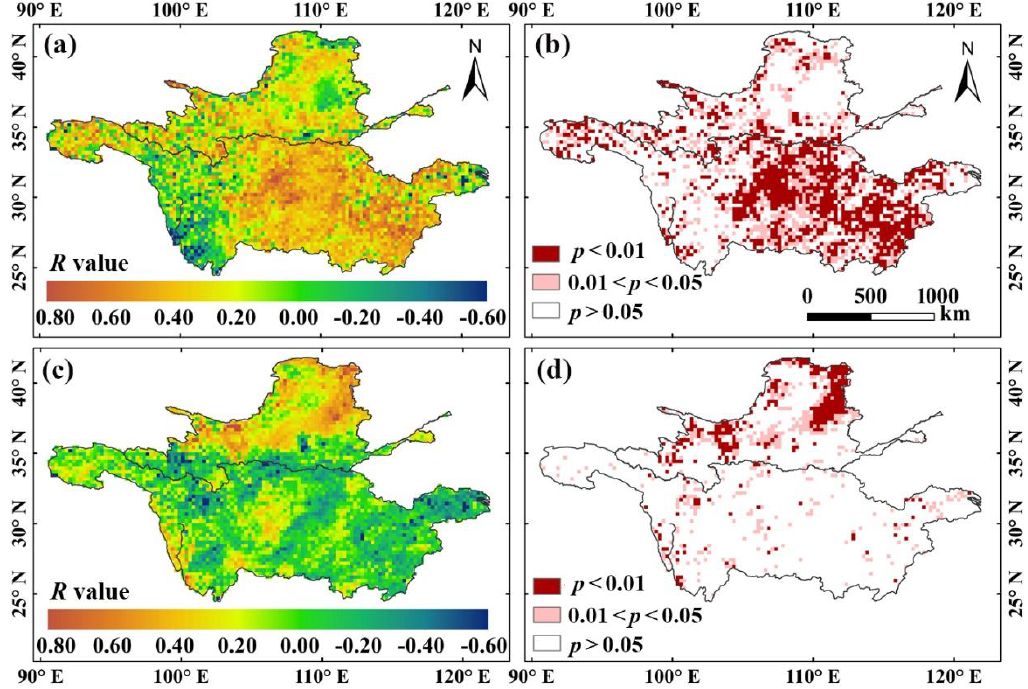
Figure 5. Spatial distribution of the correlations and significance between TEM ( a , b ), PRE ( c , d ), and NDVI.